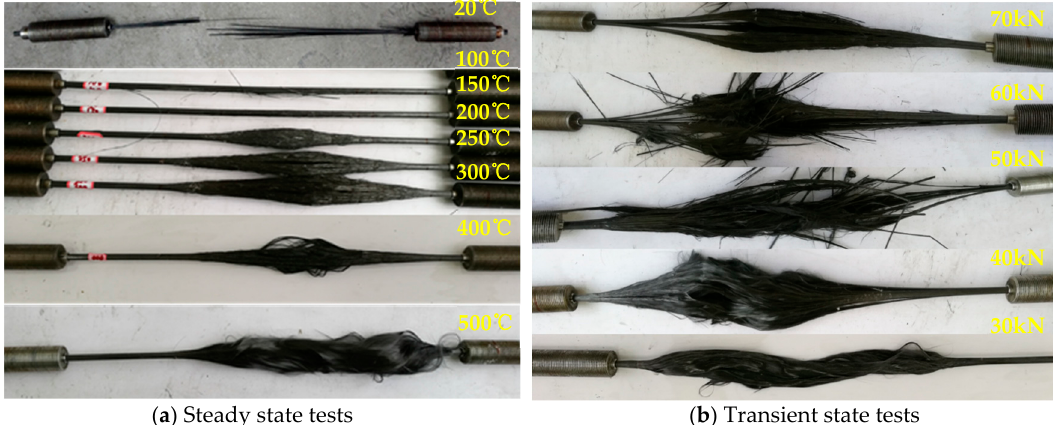
Figure 7. Failure modes of CFRP tendons at elevated temperatures.